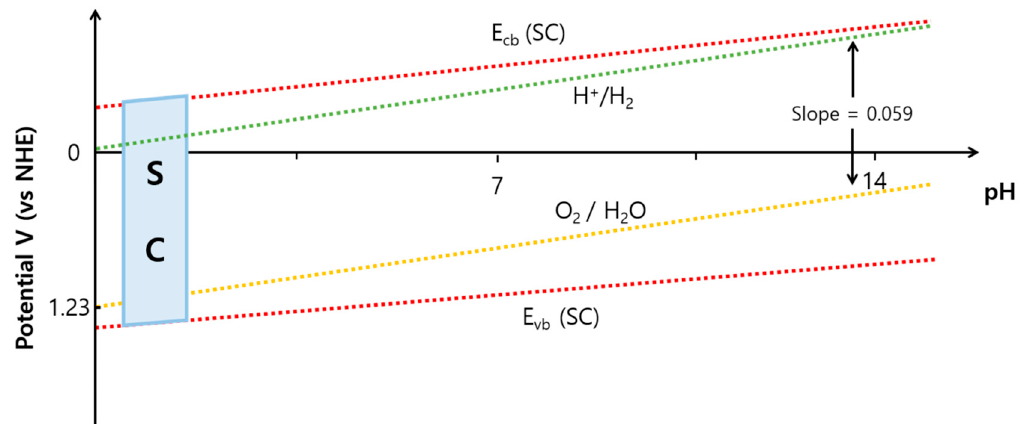
Figure 2. pH dependence of the band edge positions in an aqueous electrolyte solution. H + /H 2 and O 2 /H 2 O potentials follow the Nernstian relation, which has a variation of 0.059 V/pH at 25 ◦ C at 1 atm. Conversely, the slope of the semiconductor band edge position (red dotted line) according to pH could be different from that of water (green and yellow dotted